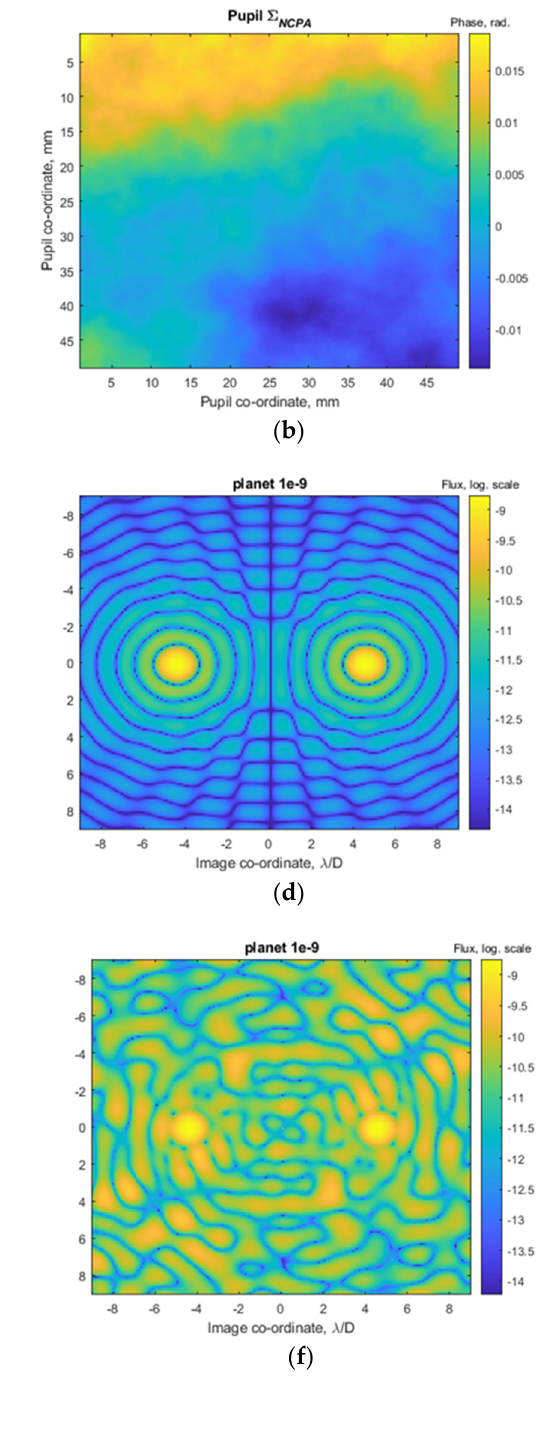
( g ) Figure 6. Simulated phase aberrations and corresponding coronagraphic images. Aberrations: ( a )— phase distribution ф (cid:3072) (cid:3116) (cid:4666)𝑢 , 𝑣(cid:4667) with σ = 10 nm rms in Σ 0 plane and ( b )— ф (cid:3072) (cid:3146)(cid:3135)(cid:3148)(cid:3133) (cid:4666)𝑢 , 𝑣(cid:4667) with σ =1nm rms in Σ NCPA . ( c – f )—evaluated coronagraphic images I ( x ″ , y ″ ) at focus F ″ (see optical scheme in Figure 5) on CCD 1 field camera, computed with the PSFs peak ‐ to ‐ peak contrast between point ‐ like light sources: the planet and the star C = 10 − 9 . ( c , d )—calculated with the wavefront distortion of ф (cid:3072) (cid:3116) (cid:4666)𝑢 , 𝑣(cid:4667) . ( c )—non ‐ corrected wavefront. ( d )—corrected by setting the phase screen (cid:3398)ф (cid:3072) (cid:4594) (cid:4666)𝑢 (cid:4593) , 𝑣′(cid:4667) (cid:3404) (cid:3398)ф (cid:3072) (cid:3116) (cid:4666)𝑢 , 𝑣(cid:4667) in the plane Σ′ ( u ′ , v ′ ); here, the planet PSF and its symmetric copy were completely cleared from the speckles. In panels ( e , f ), both aberrations ф (cid:3072) (cid:3116) (cid:4666)𝑢 , 𝑣(cid:4667) and ф (cid:3072) (cid:3146)(cid:3135)(cid:3148)(cid:3133) (cid:4666)𝑢 , 𝑣(cid:4667) in the different planes Σ 0 and Σ NCPA were computed. ( e )—any wavefront correction was not applied. ( f )—wavefront correction was applied by setting phase screen – ф′ (cid:3072) (cid:4594) (cid:4666)𝑢 (cid:4593) , 𝑣′(cid:4667) (cid:3405) (cid:3398)ф (cid:3072) (cid:3116) (cid:4666)𝑢 , 𝑣(cid:4667) in the plane Σ′ ( u ′ , v ′ ). ( g )—radially averaged profile of coronagraphic image of panel ( f ). Shown in Figure 6, the simulation results were obtained by the known phase distri ‐ butions ф (cid:3072) (cid:4594) (cid:4666)𝑢 (cid:4593) , 𝑣′(cid:4667) , ф′ (cid:3072) (cid:4594) (cid:4666)𝑢 (cid:4593) , 𝑣′(cid:4667) in the plane of wavefront correction of Σ′ = ( u ′ , v ′ ). This is possible in the simulation; however, practically, one needs to measure phase distributions for its corrections. Therefore, next, we have modified our numerical experiment to check how to determine phase ф (cid:3072) (cid:3116) (cid:4666)𝑢 , 𝑣(cid:4667) by the PSI four ‐ step phase ‐ shifting technique down ‐ stream from the coronagraph. PSI was applied to half of the pupil plane Σ′ ( u ′ , v ′ ) for the wavefront correction in the AO LC SLM plane Σ′ ( u ′ , v ′ ). The images obtained by the sim ‐ ulation of the PSI technique have been found to coincide with coronagraphic images shown in Figure 6 in panels (c)–(f).